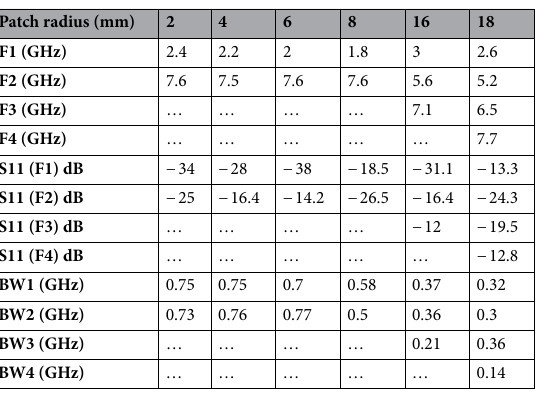
Table 10. Electrical parameter details for Antenna2 with respect to patch radius variations using a feedline length of 25